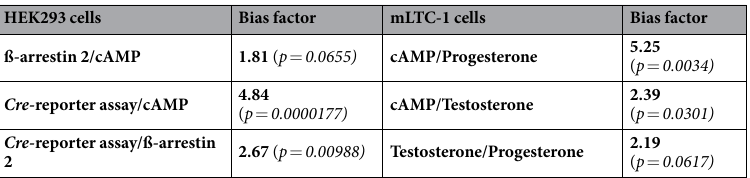
Table 3. Bias factor on the different responses in HEK293 and mLTC-1 cells. The bias factor values of each response pair reflect the biased agonism of rhLH towards the first response compared to the second, all in comparison to rhCG taken as the reference